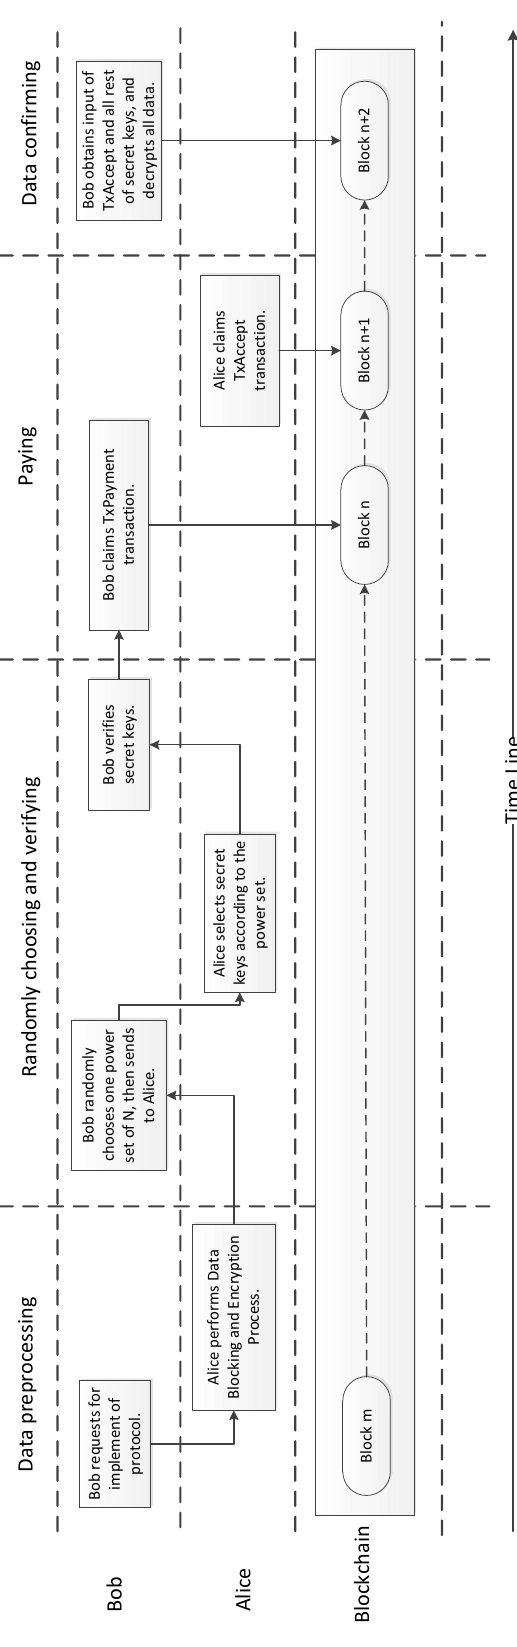
Figure 3. Protocol